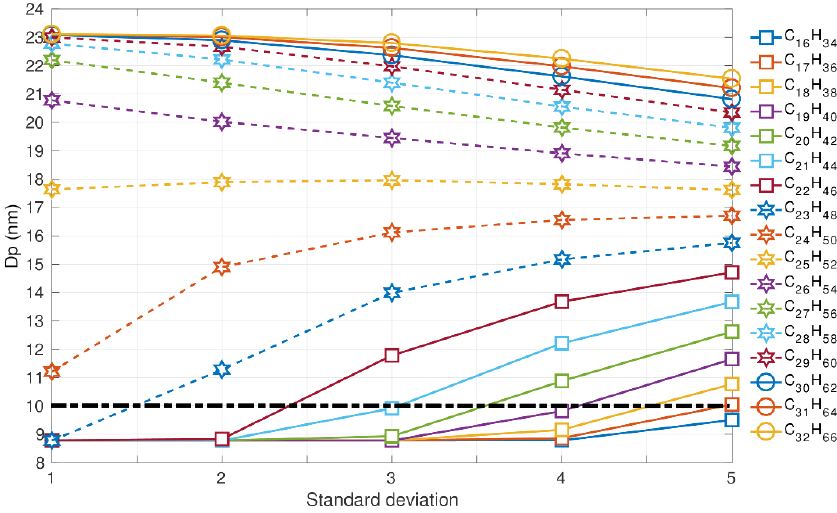
Figure 5. Nucleation-mode peak diameter D p (nm) at 100s of simulation depending on the modal composition and the composition standard deviation. The initial nucleation-mode peak diameter is at 23nm (not shown on the figure).Vapour pressure data follows Compernolle et al. (2011).